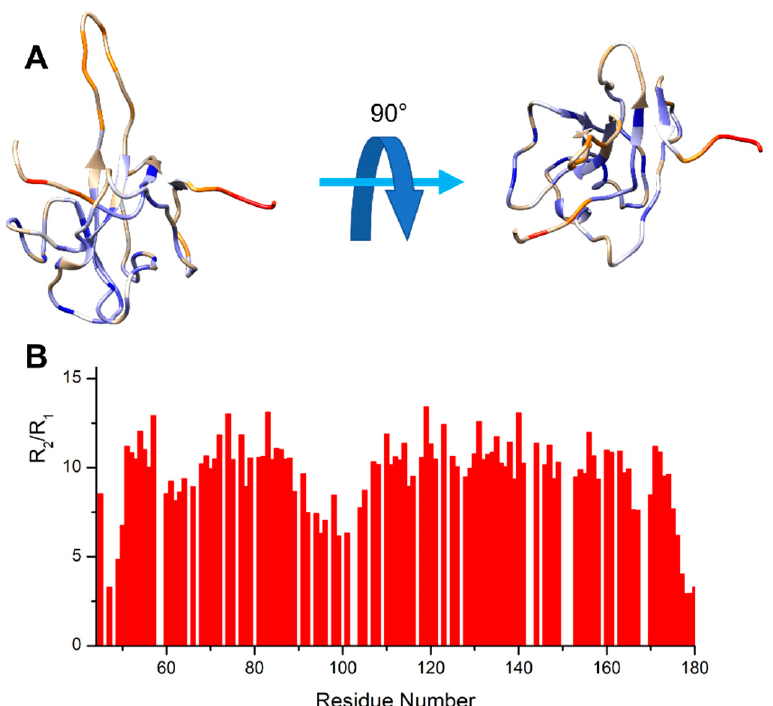
Figure 6. The NTD protein construct from two different views is reported in panel ( A ). The protein construct is colored on the basis of the R 2 / R 1 values, which gives a first estimation of the correlation time. The residues with lower R 2 / R 1 values are reported in red, while those with higher values are reported in blue. Panel ( B ) shows the R 2 / R 1 values against the residue number.